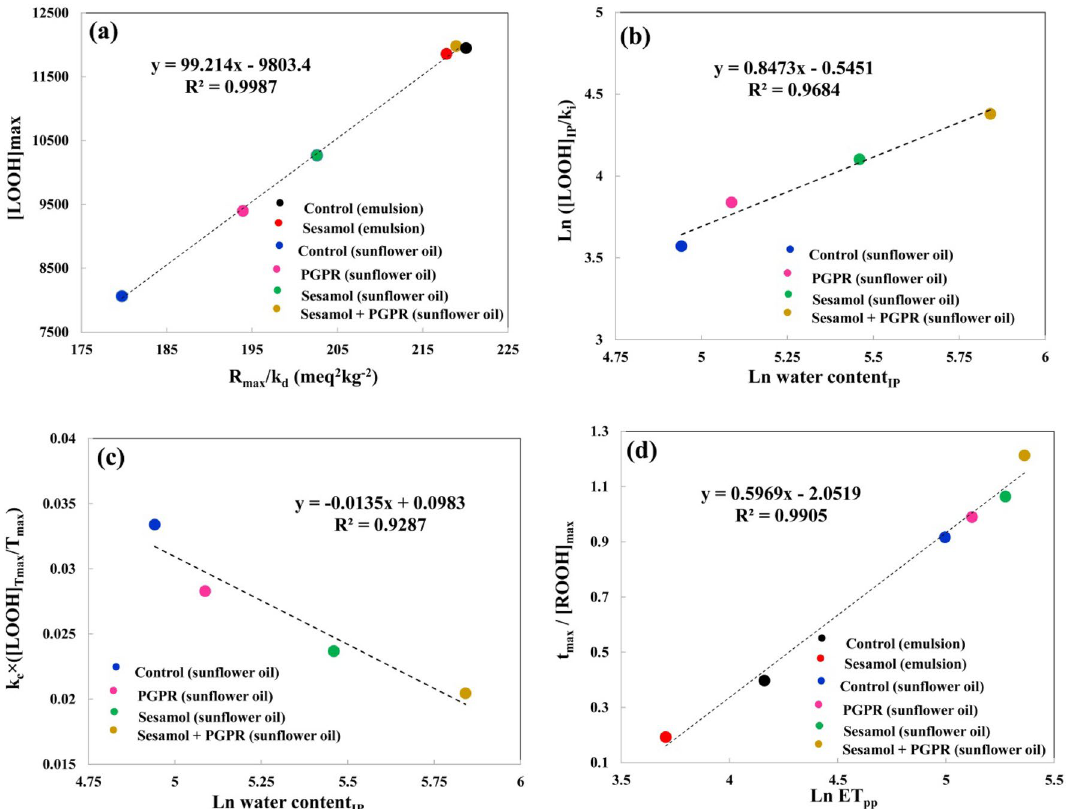
Figure 4. ( a,d ) Relationships between various kinetic parameters related to the propagation stage of sunflower oil and its oil-in-water emulsion samples and ( b,c ) relationships between water content at IP point and kinetic parameters related to the initiation and propagation stages of sunflower oil during peroxidation at 55 °C. IP induction period, k i the pseudo-zero order rate constant at the initiation stage, [ LOOH ] IP lipid hydroperoxides concentration at IP point, T max occurrence time of maximum rate of lipid hydroperoxide formation at propagation stage, R max maximum rate of lipid hydroperoxide formation in the propagation stage, [ LOOH ] Tmax lipid hydroperoxides concentration at the point of T max , k c pseudo-first order rate constant of LOOHs formation at the propagation stage, k d pseudo-second order rate constant of LOOHs decomposition at the propagation stage, ET pp end time of propagation stage, and [ LOOH ] max maximum concentration of produced